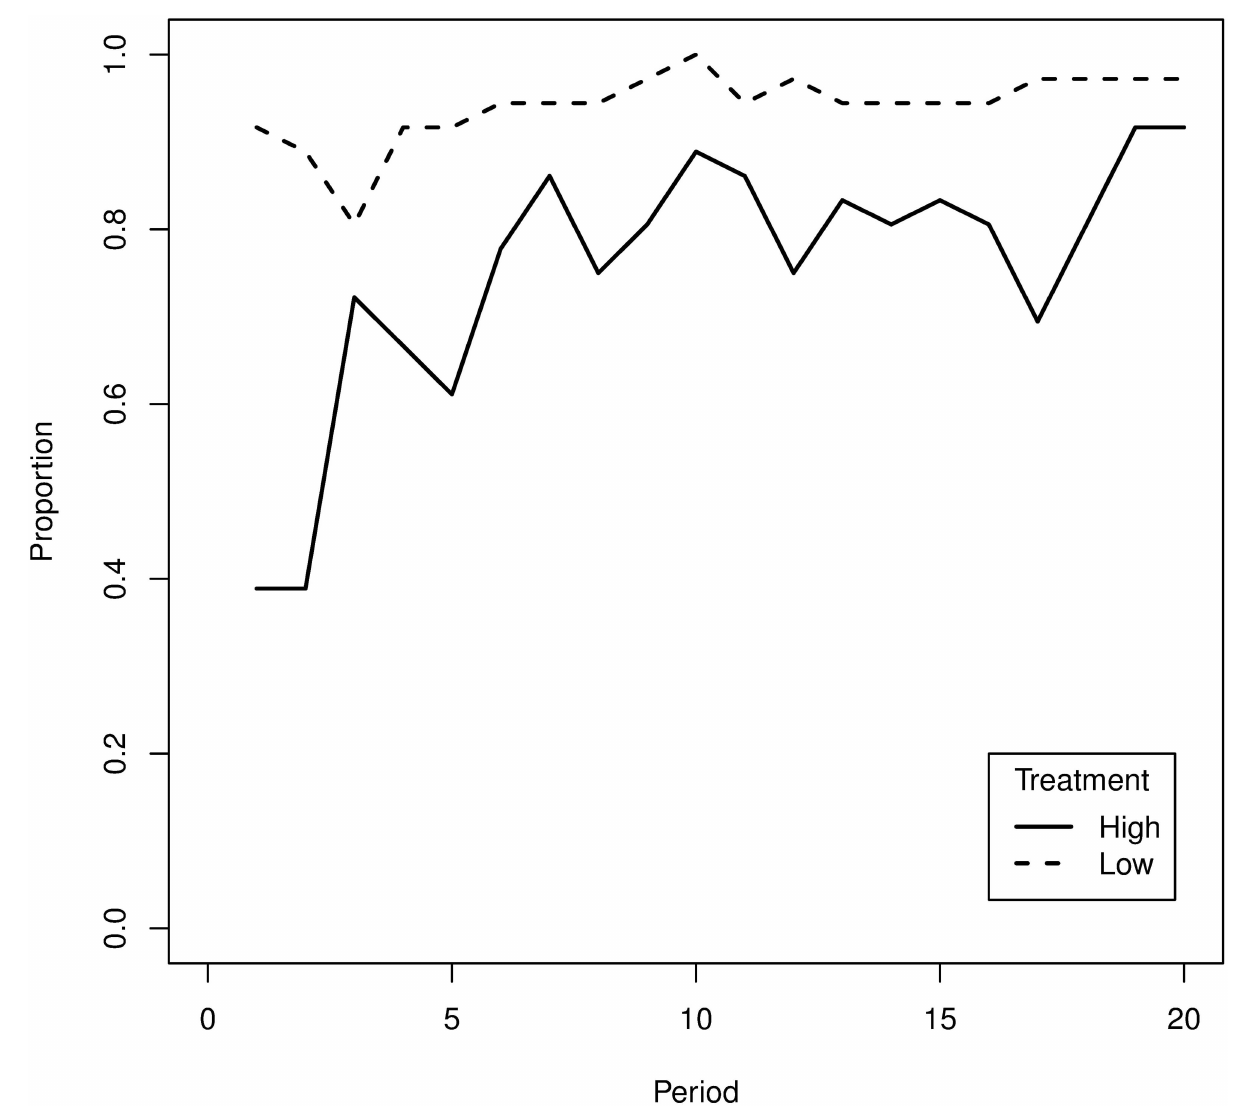
Fig 4. Share of intervals containing the true